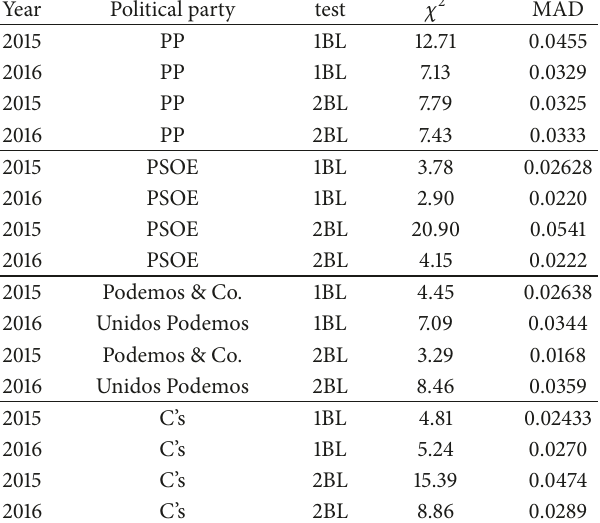
Table 3: 𝜒 2 values of conformance to 1BL and 2BL for each political party extracted from the analysis performed when we aggregate votes at the precinct